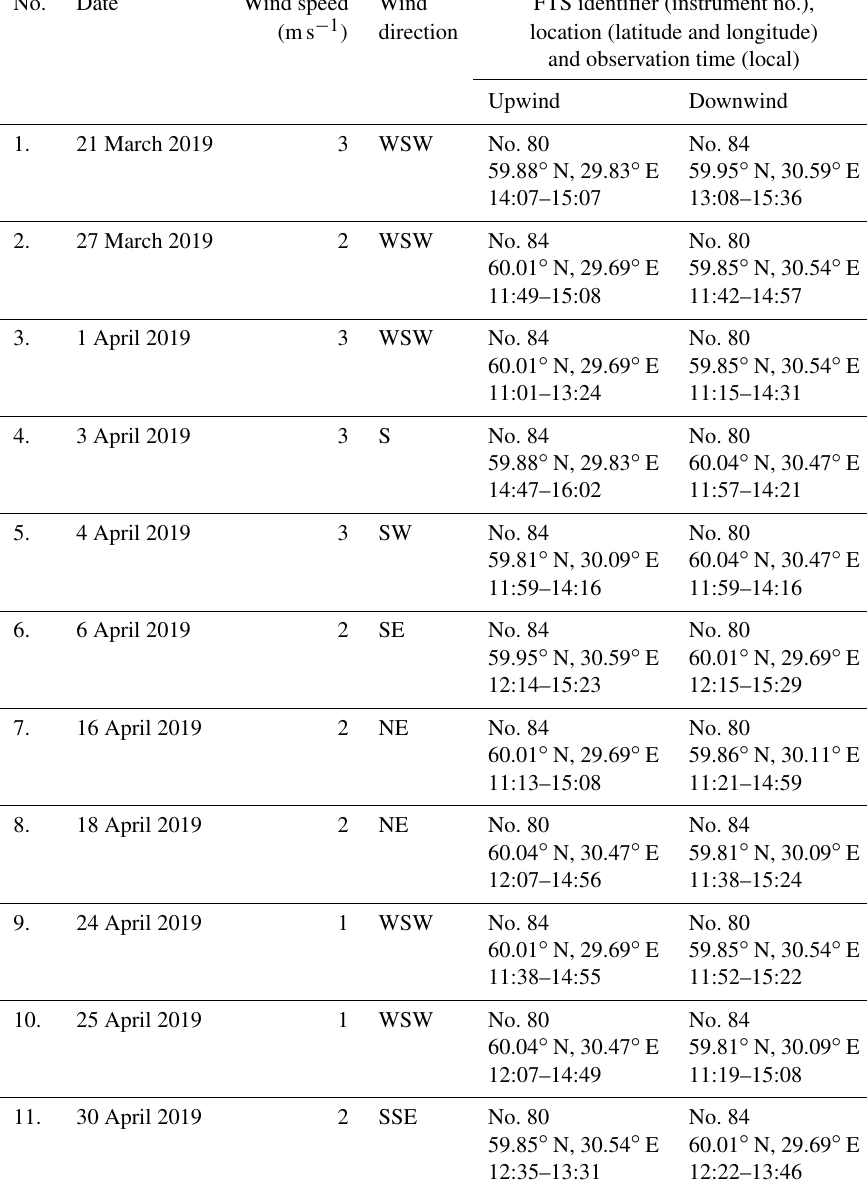
Table 1. The EMME-2019 field campaign details, including the dates of experiments in 2019 and the locations of FTS instruments during the upwind and downwind observations. The data on the direction and speed of the surface wind correspond to observations at one of the meteorological stations in the centre of St Petersburg at local noon (http://rp5.ru/Weather_archive_in_Saint_Petersburg, last access: 11 March